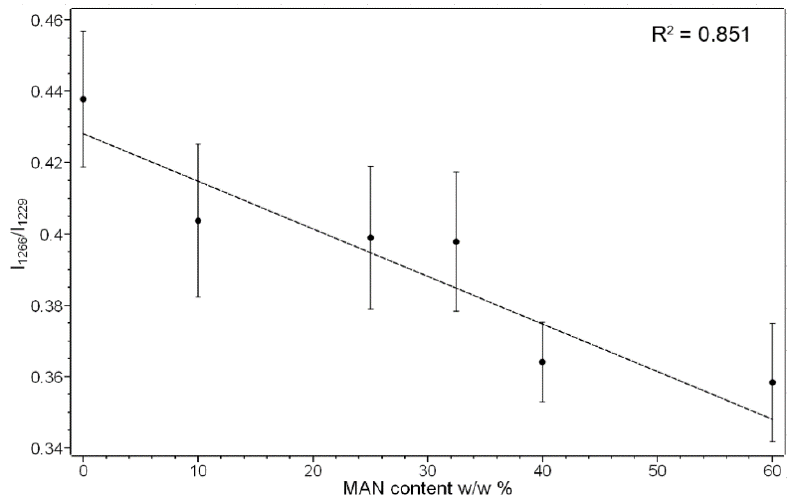
Figure 5. Trend of the I 1266 /I 1229 Raman intensity ratio as a function of the weight gain (i.e., MAN content w / w %) for the silk fibroin fibers grafted with MAN.